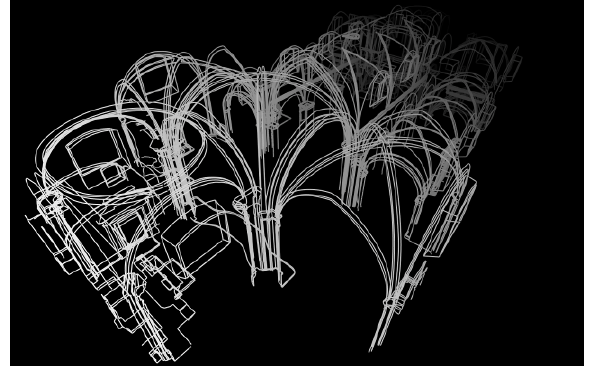
Figure 27. Technical documentation in 3D space